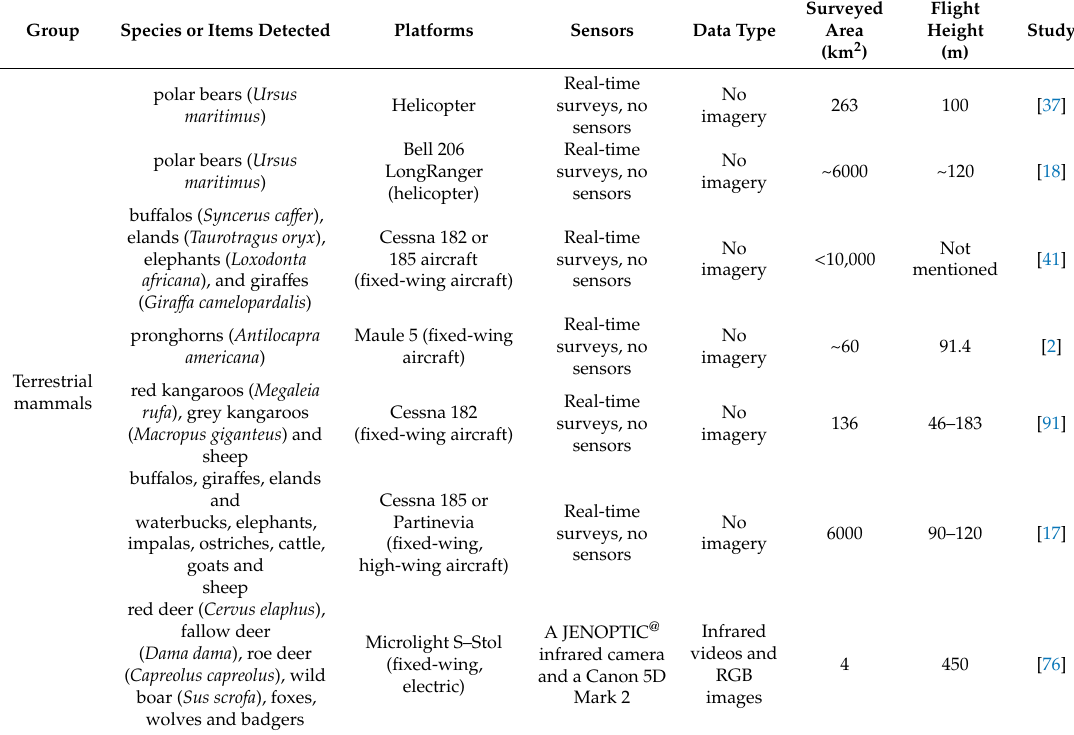
Table 4. Manned aerial surveys of wild